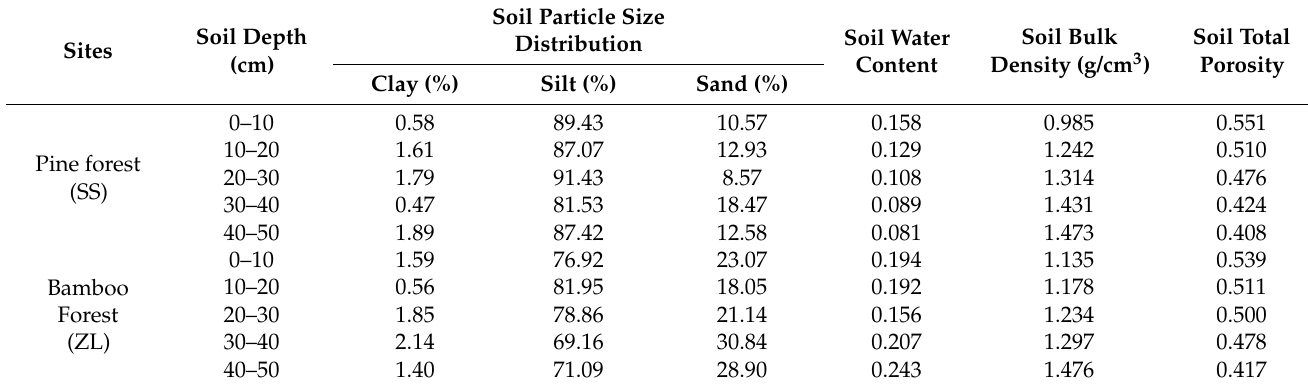
Table 2. Soil physical properties of the two sites.